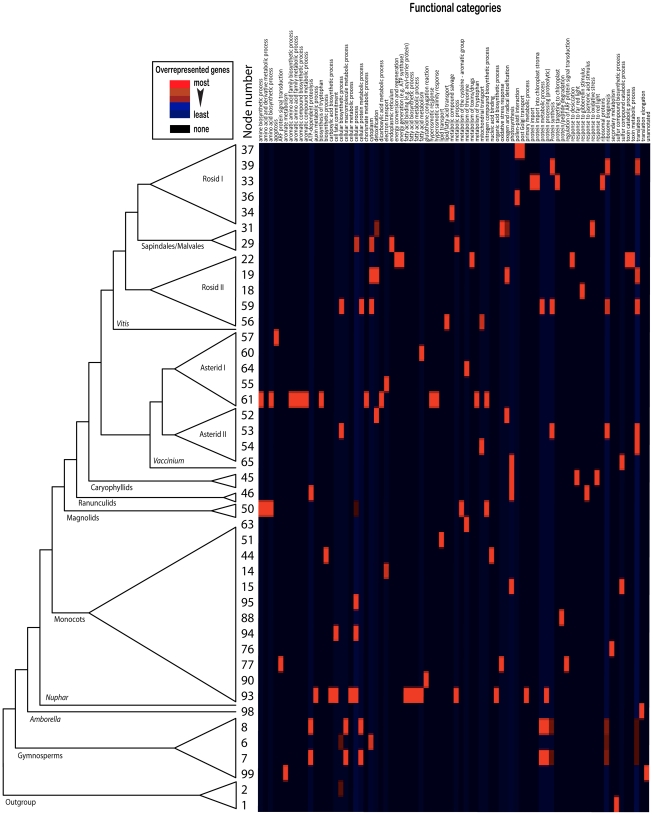
Distribution Map of Overrepresented GO Terms per Node.Each GO/MIPs category is shown in the upper axis. Color gradients show differences in proportions of these genes, with red being the category with the highest counts, light blue the least counts, and black with no match to any category. Overrepresentation is estimated on per-node basis. The reference tree is based on the MP-30 phylogenetic tree, and can be used to locate the relative position of a node represented by a heatmap row. The node numbering here corresponds to the node labels in Figure S7. Heat map constructed based on the Arabidopsis genome (source: http://noble.gs.washington.edu/prism – accessed on February 2009).